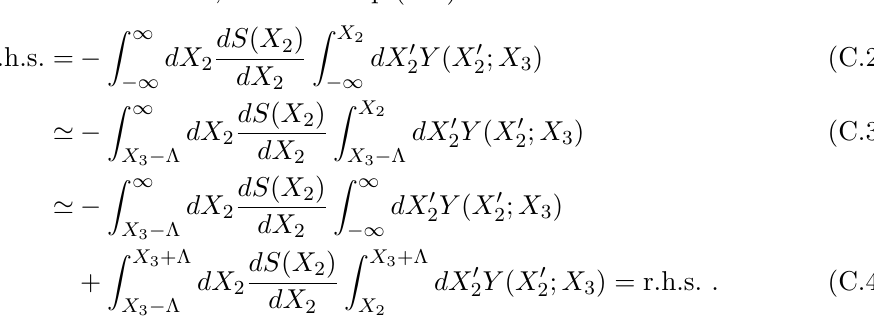
), centered at 50 AU: N ( X ) for the red line; a 2 2 ) cos( X ) / N ( X ) cos( X 2) for the 2 2 2 2 /